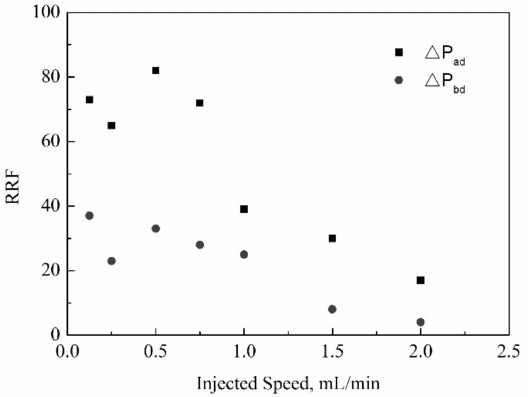
Figure 6. The change of RRF during the subsequent water flooding vs. the injection